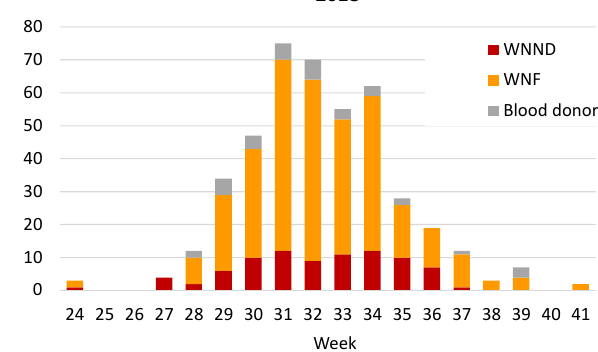
Figure 2. Epidemic curves of human cases of WNV infection according to the week of the onset of symptoms or WNV nucleic acid testing (NAT)-positive index blood donation, Veneto region, northern Italy, 2016, 2017, 2018. Please note the di ff erent scales of the Y-axis among graphs. WNND: West Nile neuroinvasive disease; WNF: West Nile fever; blood donor: WNV NAT-positive blood